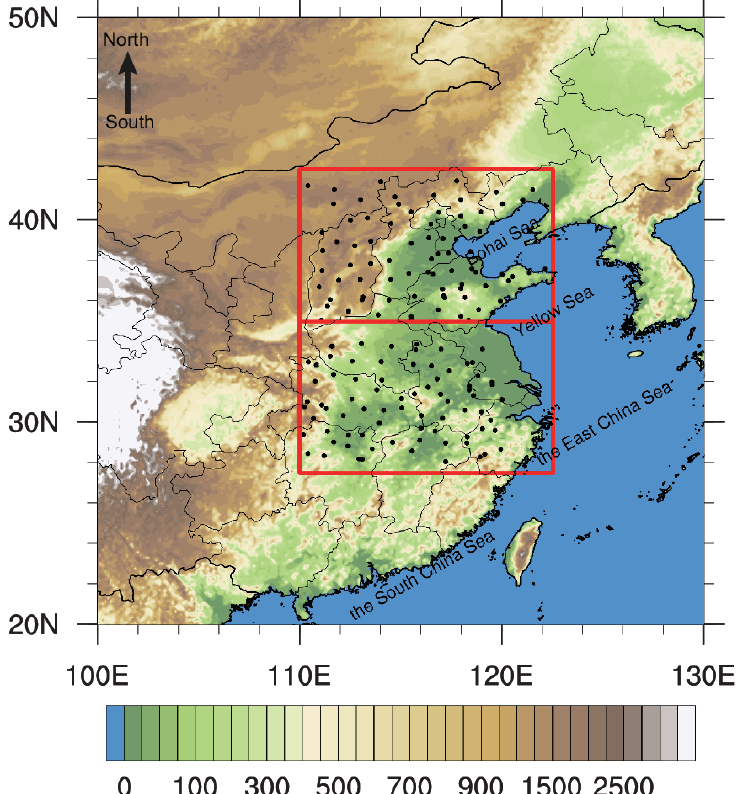
Figure 1. Spatial distribution of 74 gauge stations (solid dots) in NC and 76 gauge stations (solid dots) in the Yangtze River Valley (YRV) region and the topography (colors, m). The topography data were derived from the Global Land One-km Base Elevation Project database (http://www.ngdc.noaa.gov/mgg/topo/globe.html).